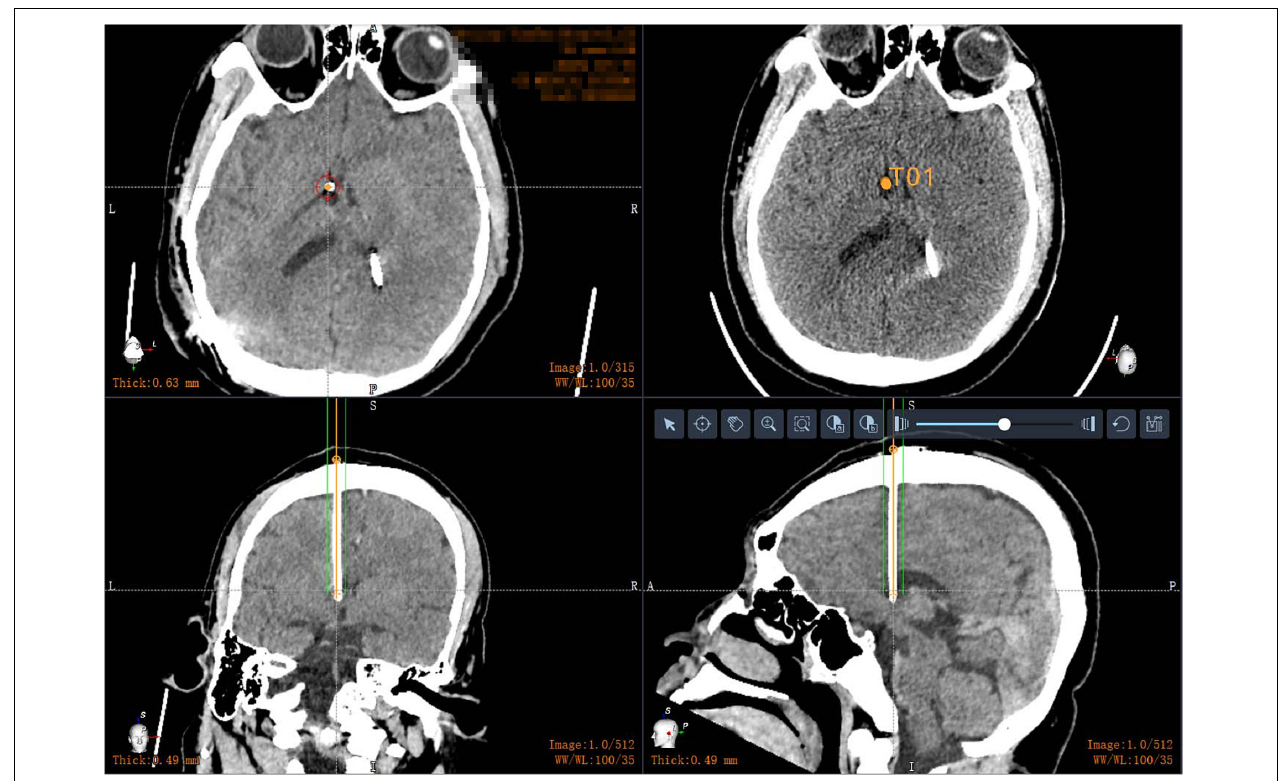
FIGURE 5 | Postoperative CT in patients with small ventricles: robot-assisted drainage tube precision